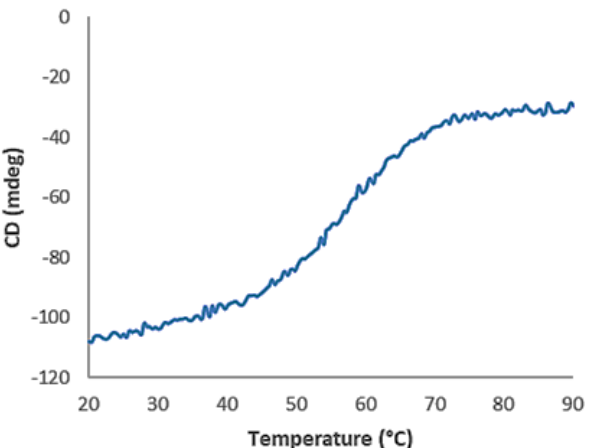
Figure 2. The CD (in mdeg) is plotted as a function of temperature. The Tm value was determined to 55 °C at maximum slope.